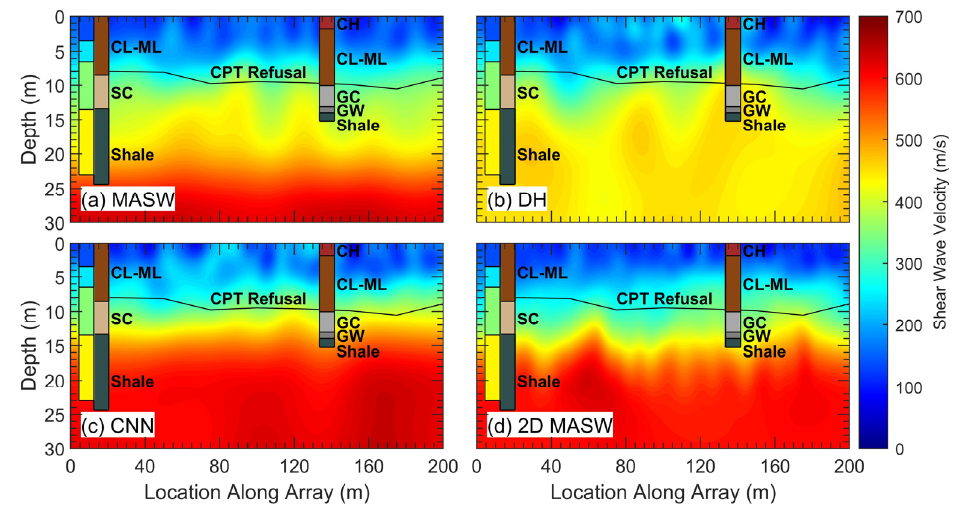
Figure 12. Borehole logs, downhole V S results, and the depth to CPT refusal overlaid on the final, updated 2D V S images at the end of FWI Stage 4 (10 to 30 Hz) for the: ( a ) MASW, ( b ) DH, ( c ) CNN, and ( d ) 2D MASW starting